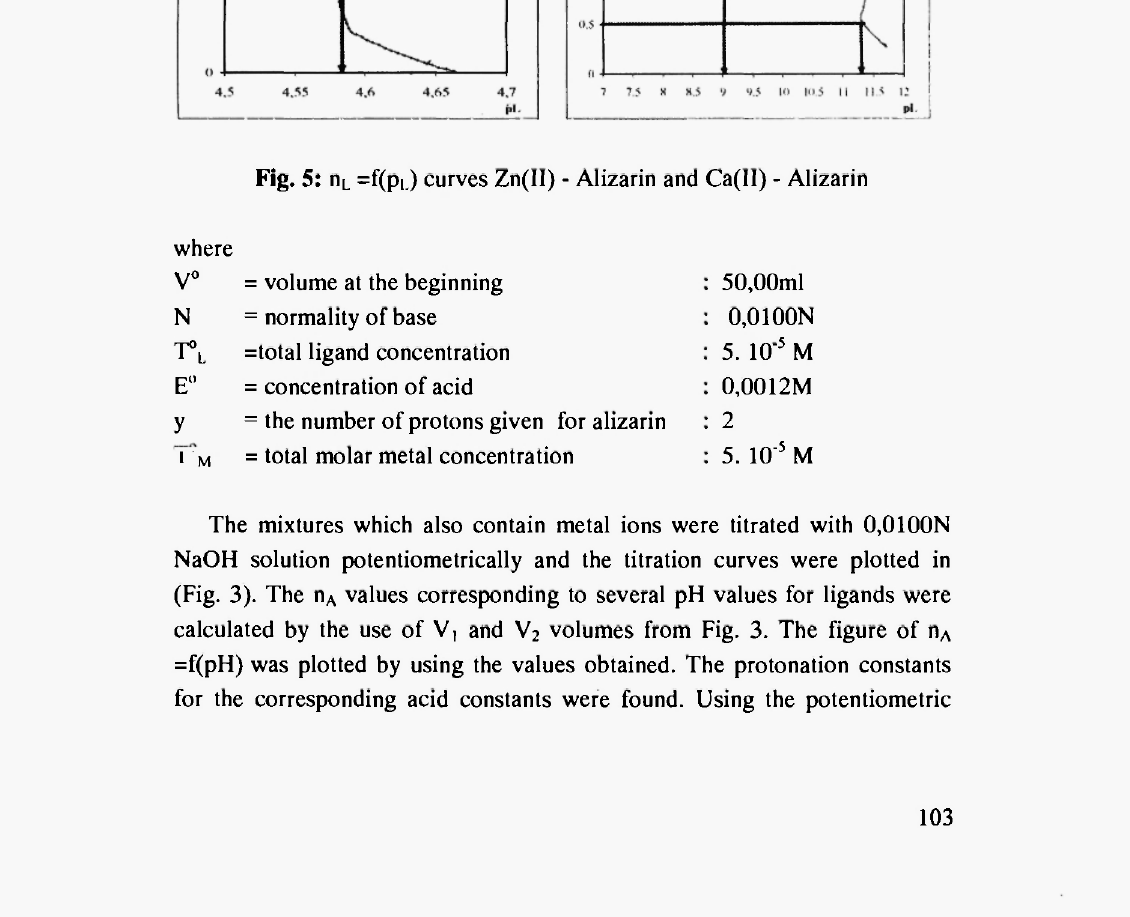
Fig. 5: n L =f(pi.) curves Zn (II) - Alizarin and Ca (II) -